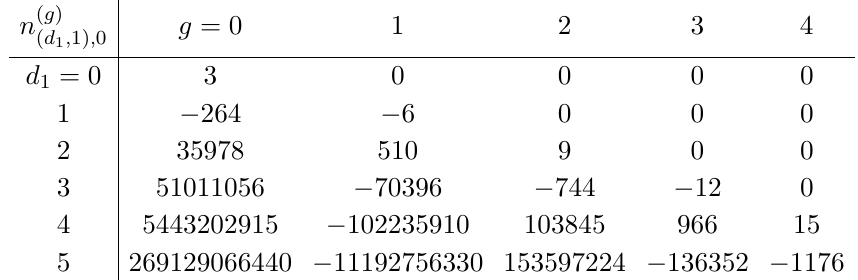
with Z charge 2 . 4 0